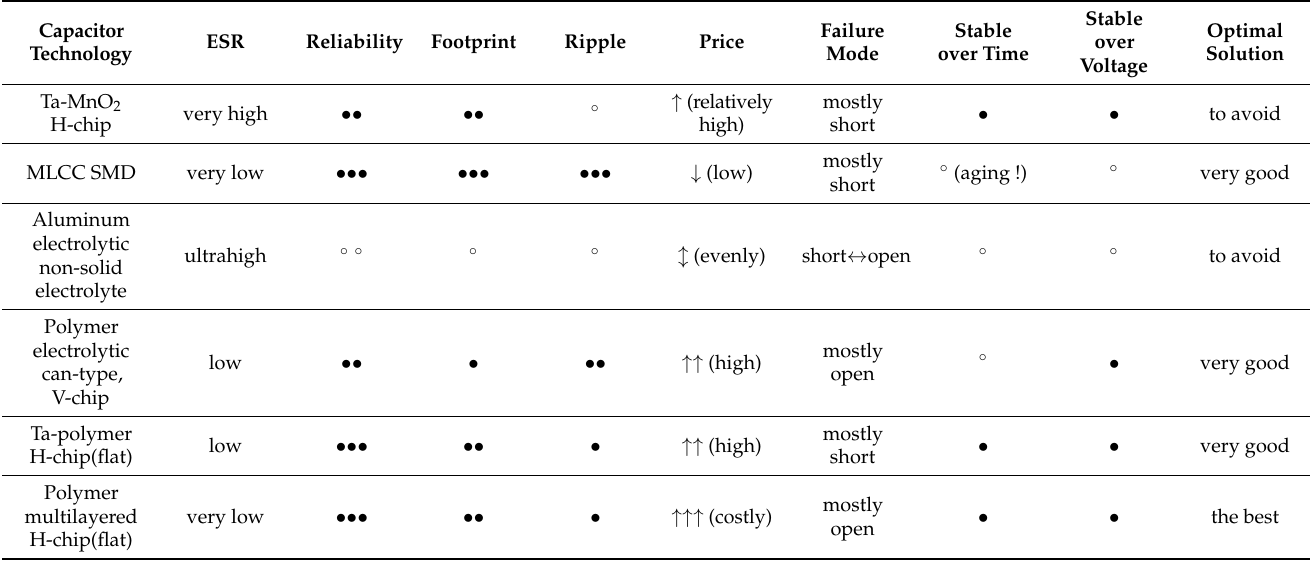
Figure 13. Data taken from measurement, photo of capacitor polymer electrolytic multilayered SMD330/8732d EEFCX0E33R as DUT ( left–center ), the actual the ripple’s waveform ( left ) and surface capacitor’s temperature which is required in reliability calculation ( right ). Table 4. Capacitors’ comprehensive characterization by their technology after measurements and